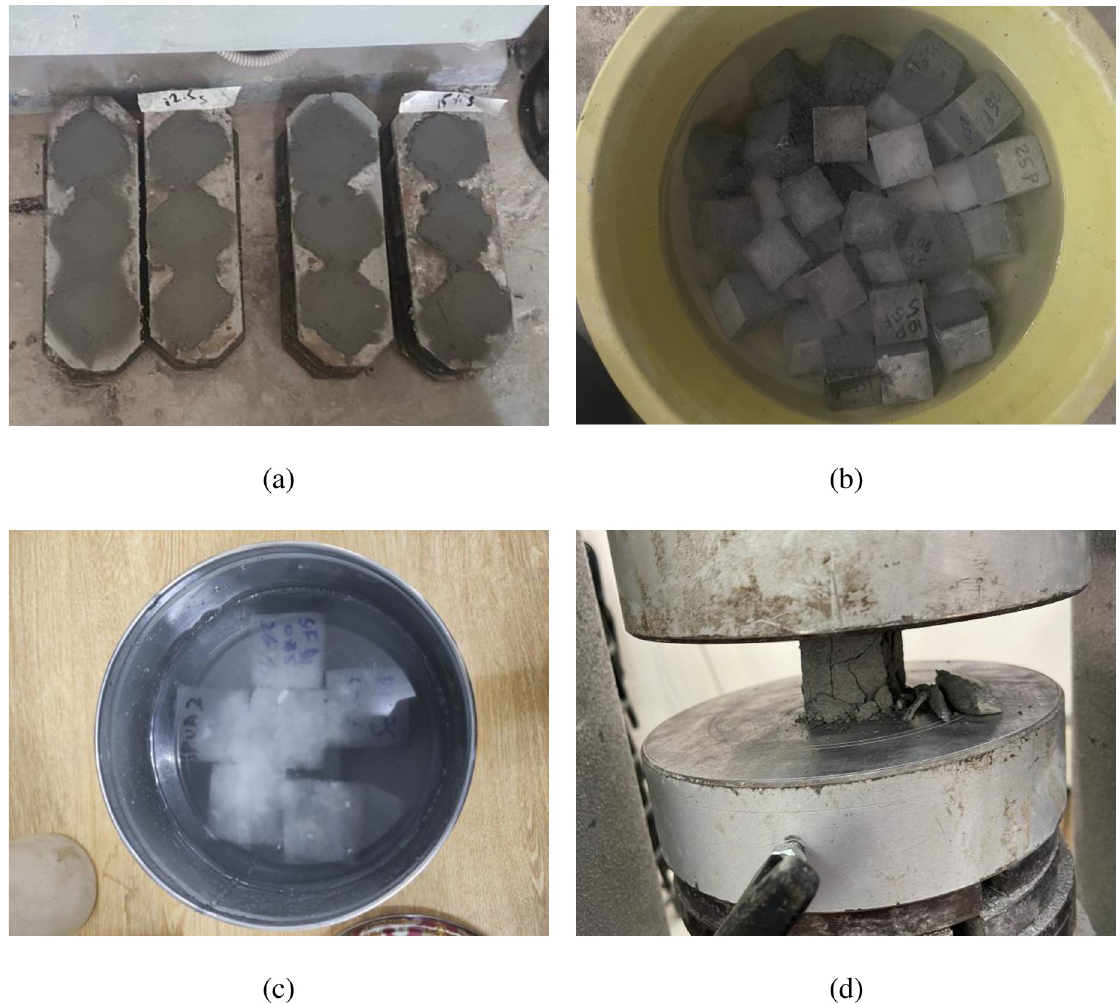
Fig 1. Experimental setup’s images: (a) Samples in molds; (b) Samples in plain water; (c) Samples in 5% H 2 SO 4 solution; (d) Testing sample under uniaxial